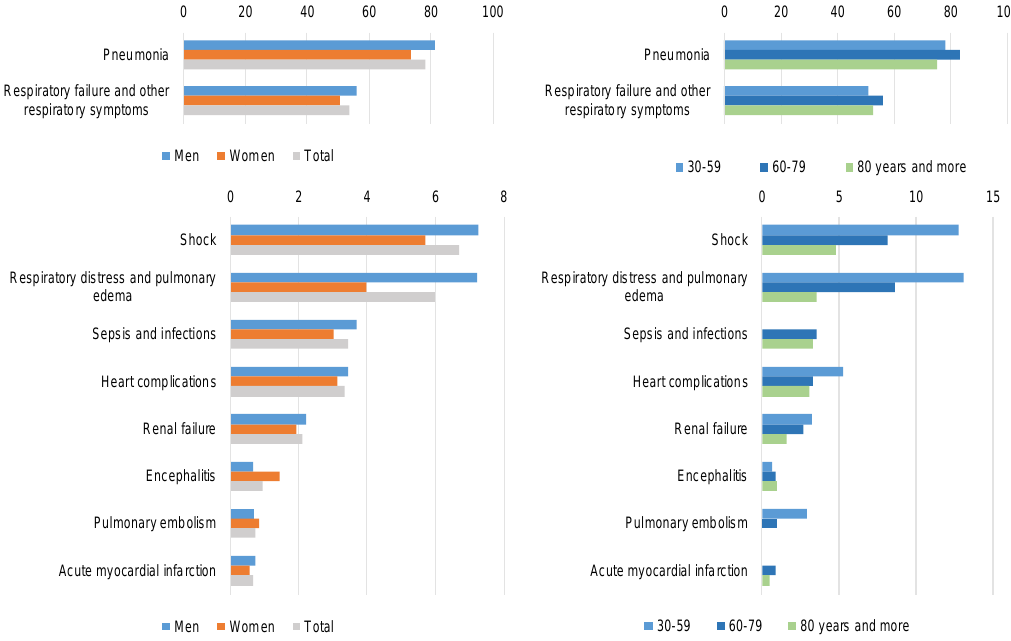
Figure 2. Main fatal complications of COVID-19 by gender and age group. Percentage of mention of the condition as complication of COVID-19 on total deaths.